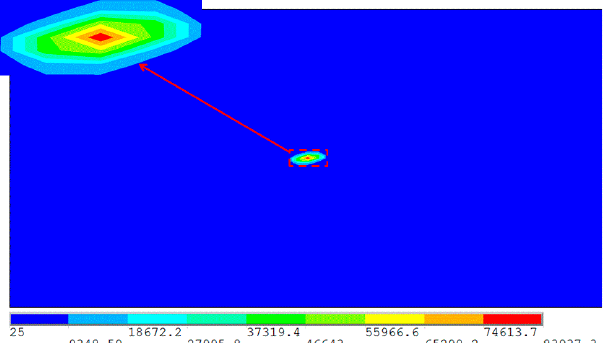
Figure 5. Temperature distribution around the attachment area of the composite reinforced panel. (Unit: °C).